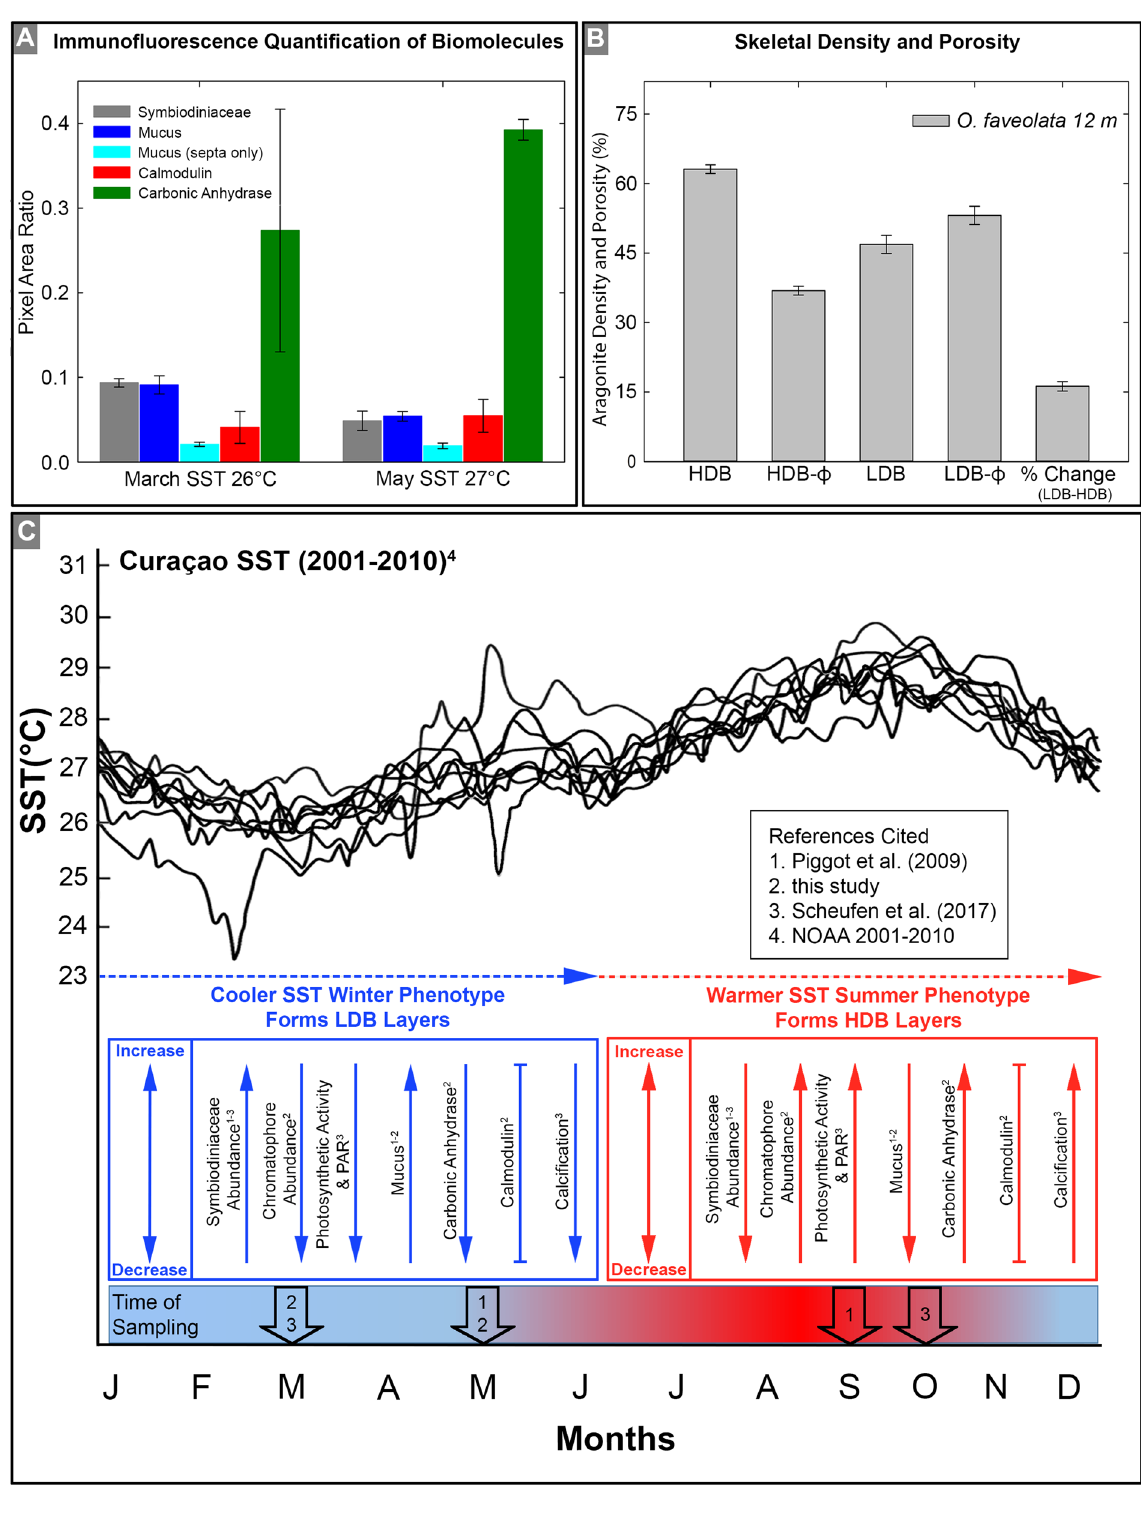
Figure 8. Quantification of Symbiodiniaceae and biomolecule tissue abundances, as well as coral skeletal density banding (CSDB), in biopsies of O. annularis and O. faveolata . ( A ) Quantification of Symbiodiniaceae and biomolecule tissue abundances in decalcified whole polyps of O. faveolata . Analyses were completed at a tissue depth of 800 µm below the uppermost polyp surfaces. All abundance measurements were normalized to the total tissue cross-sectional area of each polyp. Standard deviation error bars were calculated from measurements collected in triplicate. ( B ) Quantification of the percent density and porosity change from individual HDB and LDB layers within O. faveolata . ( C ) Summary of annual changes observed during seasonal acclimatization in O. annularis during seasonal transitions from cooler SST winter phenotype to the warmer SST summer phenotypes. Significant variations in annual SST on Curaçao (NOAA 2001–2010) provide a valuable context for evaluating changes in the tissue abundance of Symbiodiniaceae cells and biomolecules in O. annularis . In addition, other key components were included from the combined results of previous studies 30,33